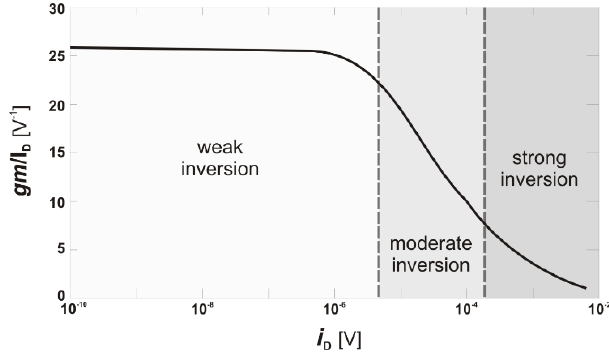
Figure 3. gm/I D versus i D . Figure 3. gm / I D versus i D .